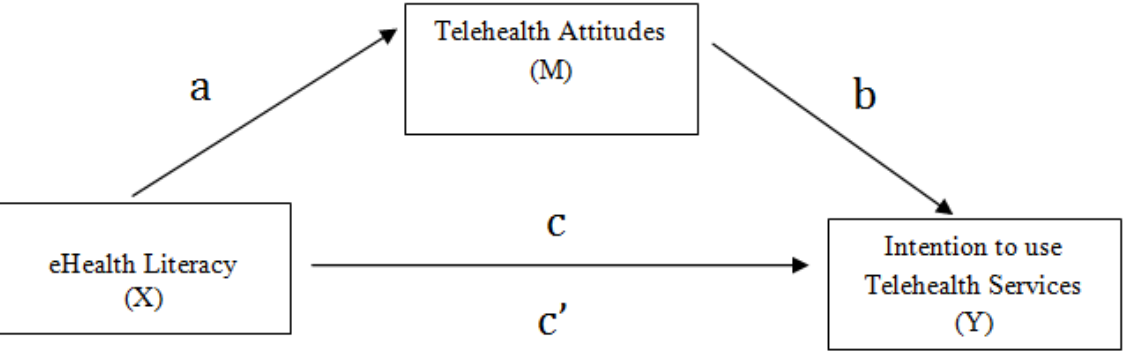
Figure 1. Path diagram of the hypothesized mediation